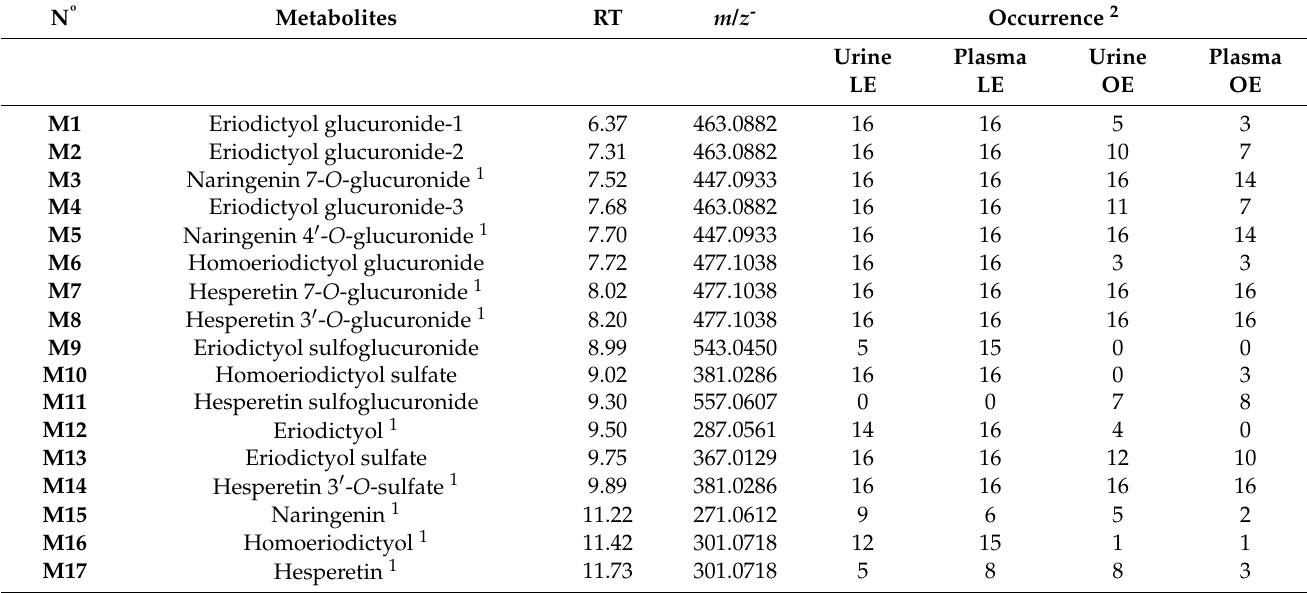
Table 3. Plasma and urine metabolites identified in volunteers ( n = 16) after consuming lemon (LE) or orange (OE) extracts.